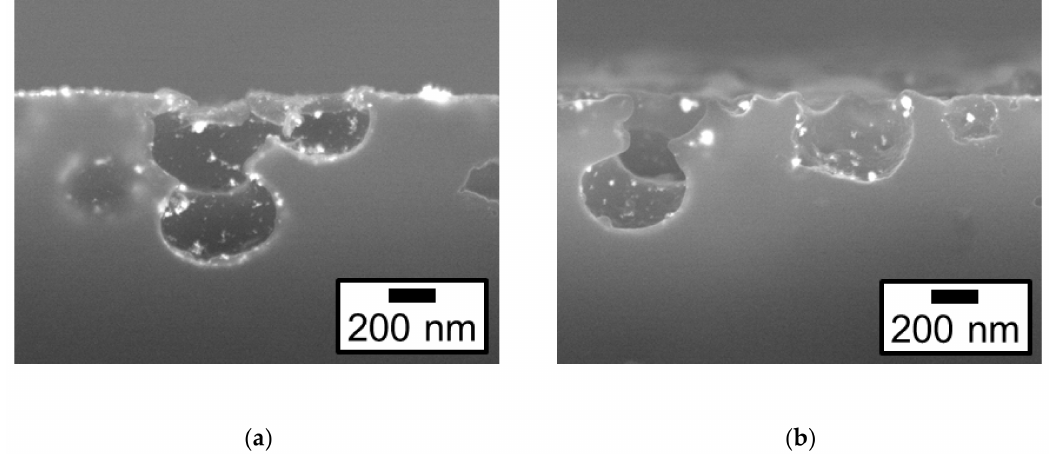
Figure 4. Cross-sectional backscattered electron images for etched samples: ( a ) Pt/ABS-Etch and ( b ) Pt/ABS-Etch&Charge.